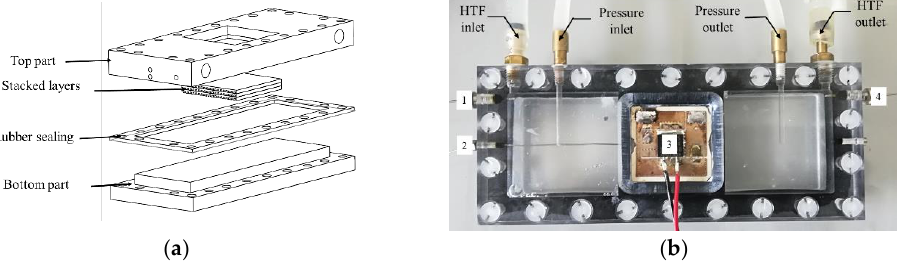
Figure 2. ( a ) Schematic of the test module parts, ( b ) a photograph of the test module showing the thermocouple locations at; (1) water inlet temperature, (2) water temperature at the middle channel of the first layer, (3) heat source middle surface temperature, (4) water outlet temperature.